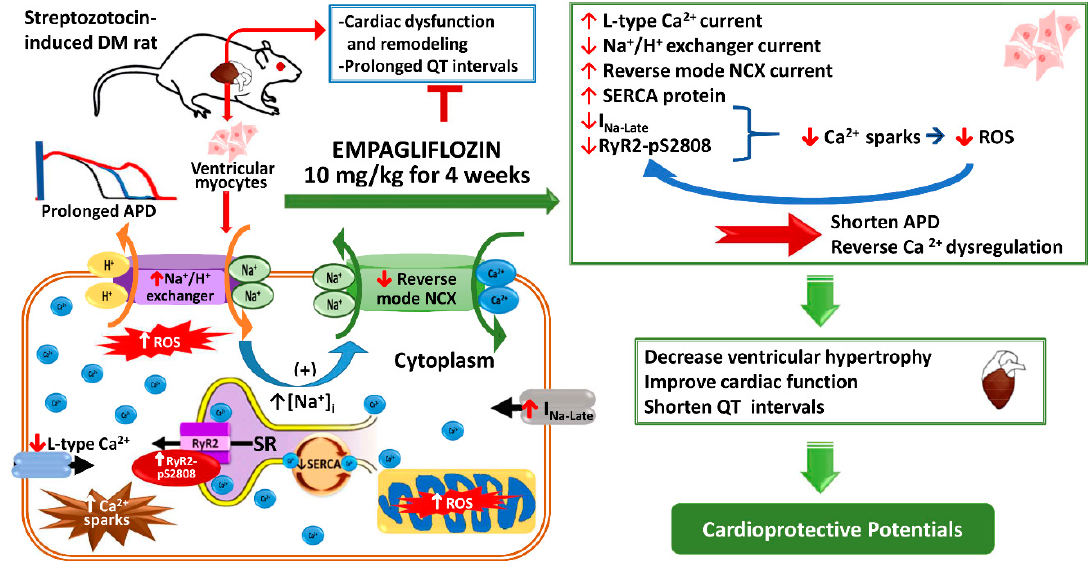
Figure 8. Schematic illustration of the proposed mechanism of action of empagliflozin in DM hearts. Empagliflozin treatment may reverse DM-induced Ca 2+ /Na + dysregulation by decreasing ROS